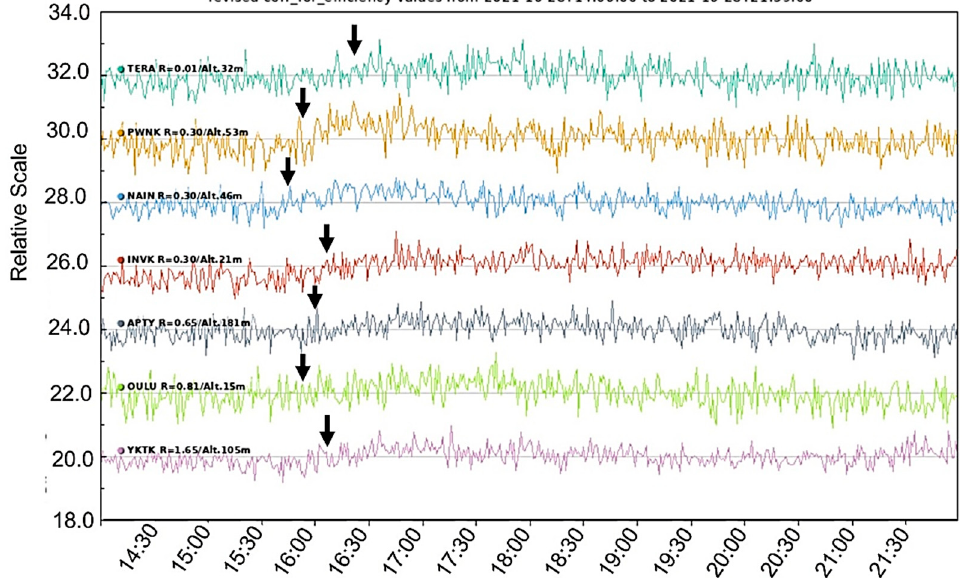
Figure 8. NM stations that detected GLE73 with small amplitude and did not give alert signal in the A.Ne.Mo.S. GLE Alert Systems.